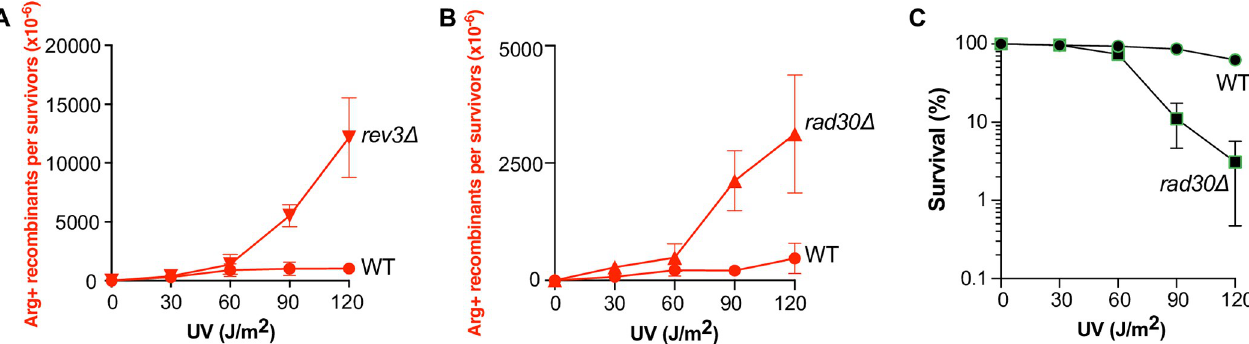
Fig 3. Channeling UV-induced DNA lesions into the HR pathway in TLS-deficient cells. (A) UV-induced [Arg+] recombinant frequencies in WT and rev3 Δ diploid cells. (B) UV-induced [Arg+] recombinant frequencies in WT and rad30 Δ diploid cells. (C) Survival of diploid rad30 Δ cells after UV